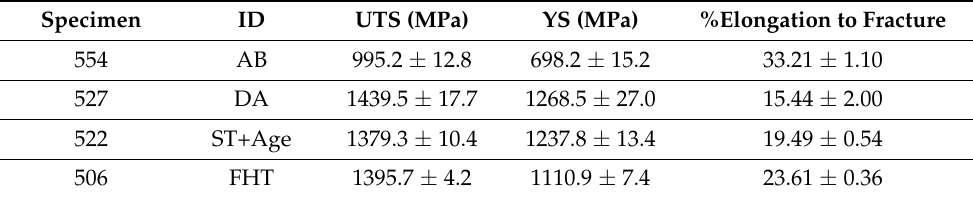
Table 5. Mechanical properties of heat treated samples as compared to the AB.